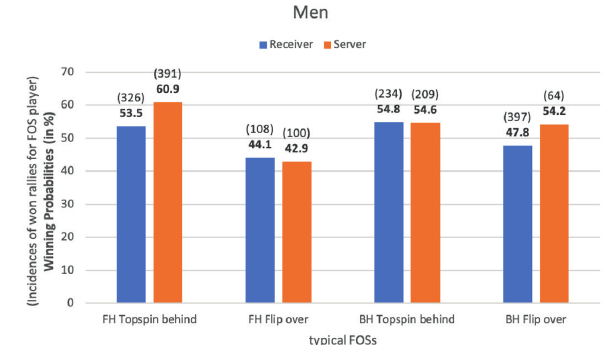
Figure 5. Incidences of won rallies and winning probabilities for the FOS player using the typical FOSs separated by serving or receiving player is performing the FOS for women’s matches.